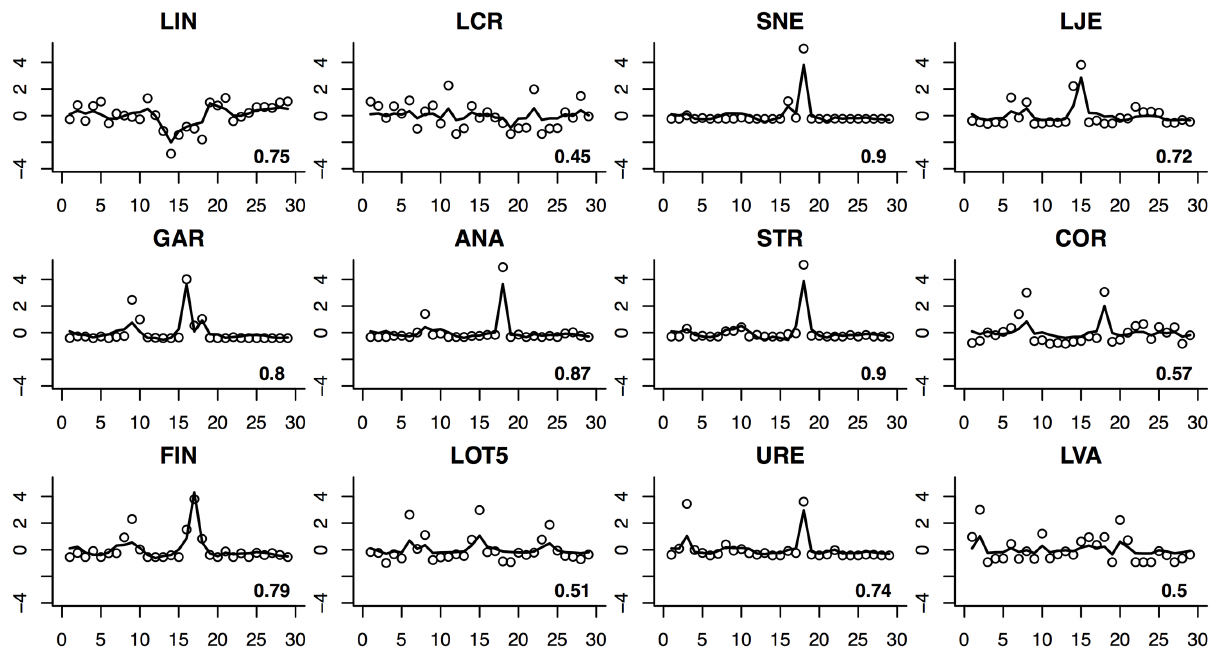
Fig 1. One-step-ahead prediction for subject 15. Each cell represents prediction for a different OTU. Solid lines depict the predicted values whereascircles indicatestandardized temporal abundances of OTUs. Abbreviations for Operational TaxonomicUnits: LIN Lactobacillus iners ; LCR Lactobacillus crispatus ; SNE Sneathia sp. ; LJE Lactobacillus jensenii ;GAR Gardnerellasp. ; ANA Anaerococcus sp. ; STR Streptococcus sp. ; COR Corynebacterium sp. ; FIN Finegoldiasp. ; LOT5 Lactobacillus otu5 ; URE Ureaplasmasp. ; LVA Lactobacillus vaginalis